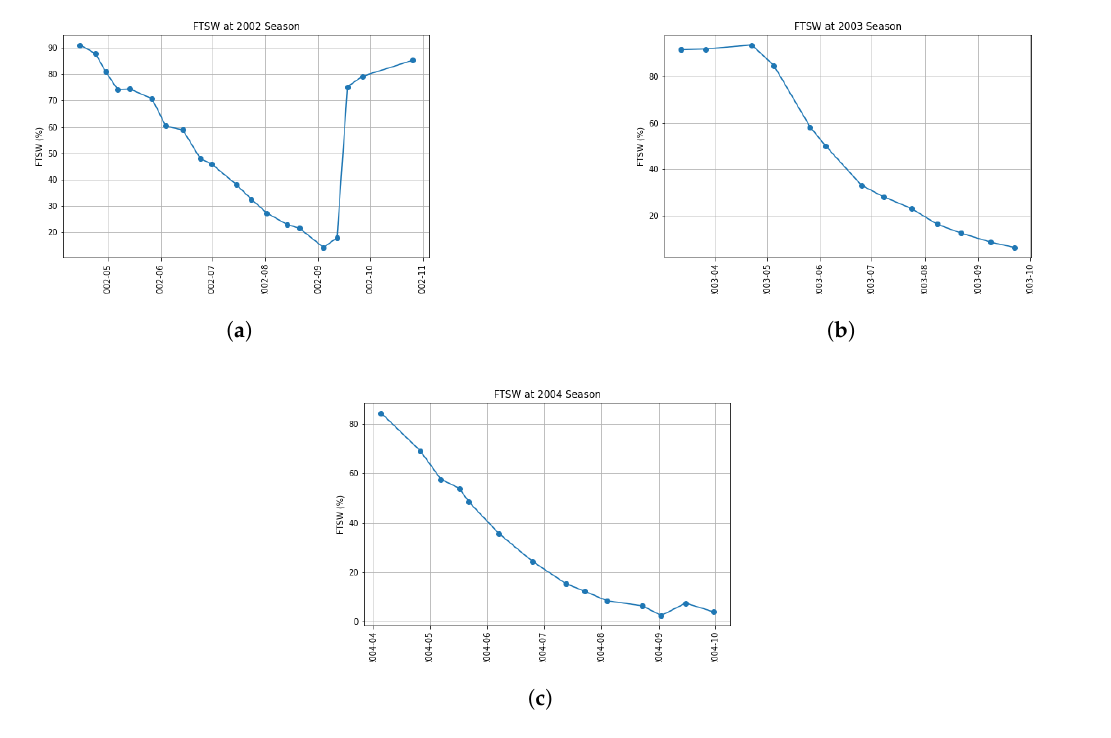
Figure 5. Calculated FTSW for Quinta de Pancas from 2002 to 2004. ( a ) FTSW in 2002 season, ( b ) FTSW in the 2003 season, and ( c ) FTSW in 2004